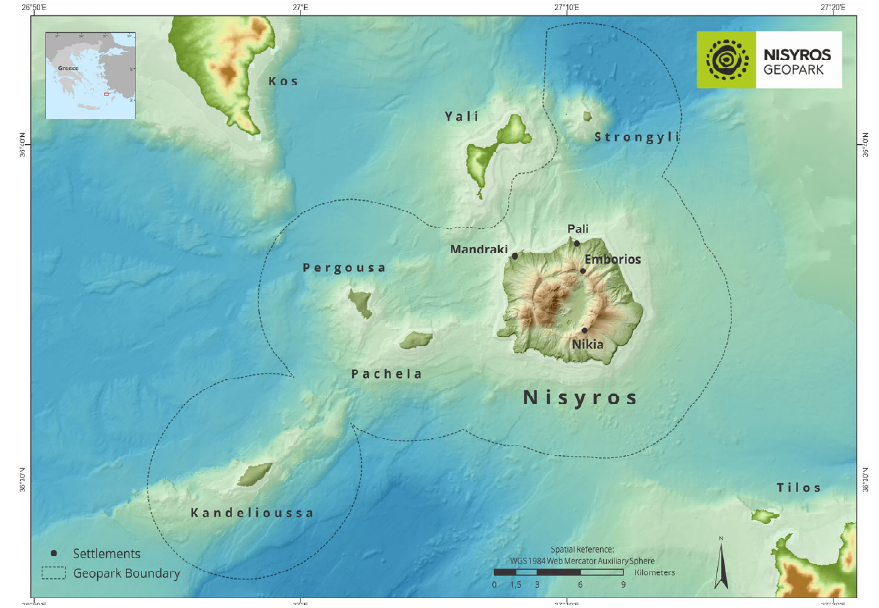
Figure 1. Geotouristic map of Nisyros aspiring UNESCO Global Geopark.